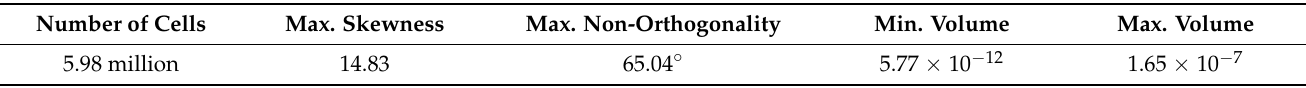
Figure 3. ( a ) Three-dimensional view of the mesh and zoomed view, ( b ) mesh for the CPUs and ( c ) mesh for the fans. Table 2. Mesh statistics for the complete